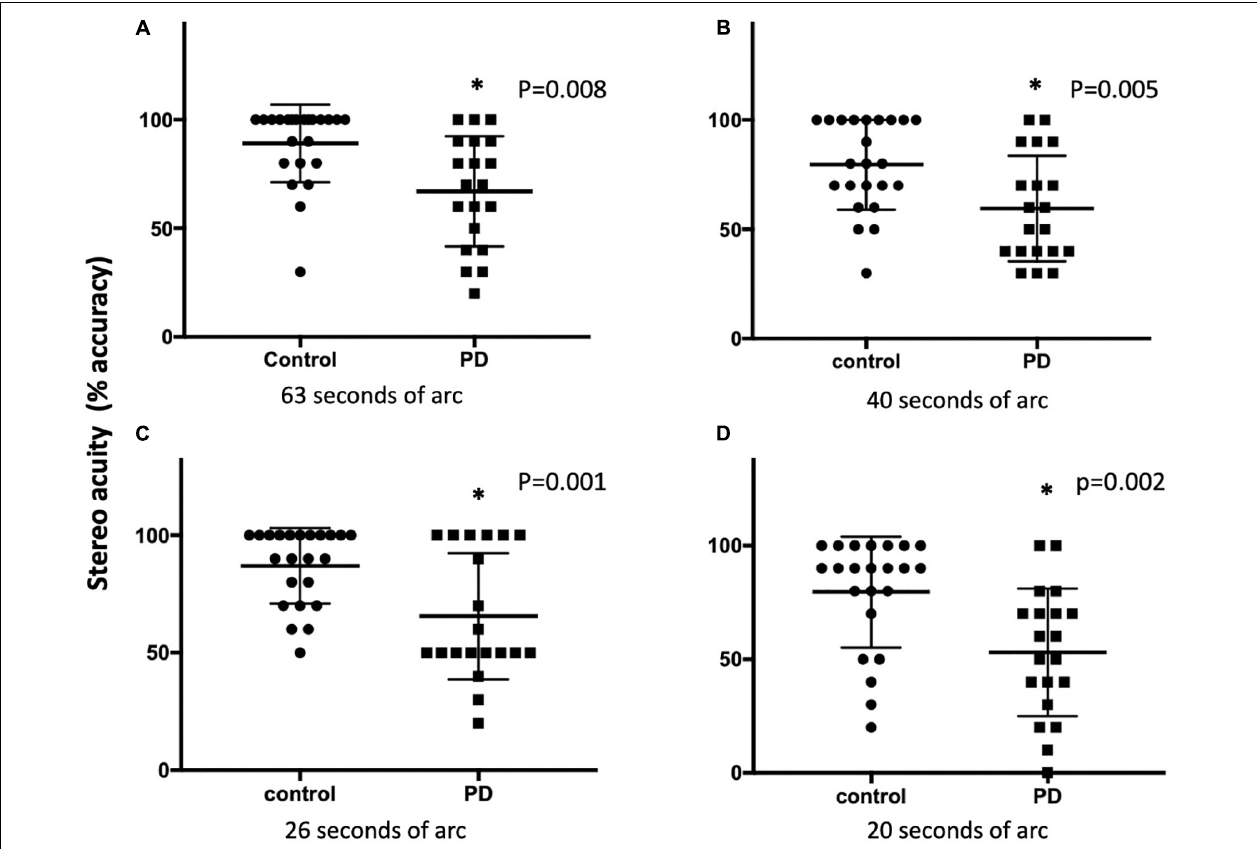
FIGURE 3 | The stereo acuity between the control and PD groups using the 3D active shutter system at 63 (A) , 50 (B) , 40 (C) , and 26 (D) arc seconds. The stereopsis was presented as percent accuracy. ∗ p < 0.05, with Mann–Whitney U -test. PD, Parkinson’s